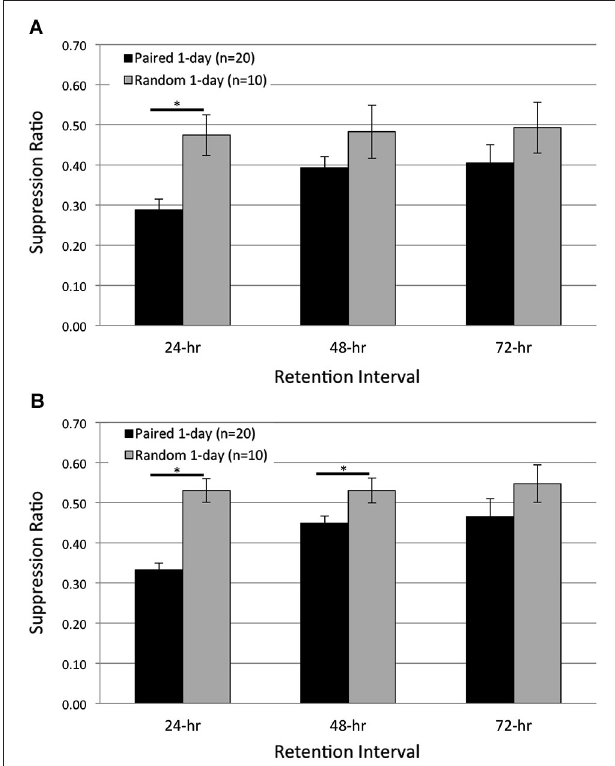
FIGURE 3 | One day of paired conditioning produces significant phototactic suppression compared to random control conditions. Summary data for start (A) and finish (B) latency suppression ratio (SR) scores measured at three different RIs post-acquisition. Animals given one session of 50 paired conditioning trials ( Paired 1-day group) showed significant phototactic suppression (i.e., smaller SR scores) compared to control animals given one session of 50 random presentations of light and rotation ( Random 1-day group), for both the start and finish latency measure. Paired 1-day animals displayed significantly greater phototactic suppression than Random 1-day animals for start latency behavior at the 24-h RI, and significantly more suppression for finish latency behavior at the 24- and 48-h RIs. These data indicate that the memory for associative conditioning has been consolidated 24 h following one session of paired conditioning. Error bars are ± S.E.M and significant p values ( p ’s < 0.05) are denoted by an